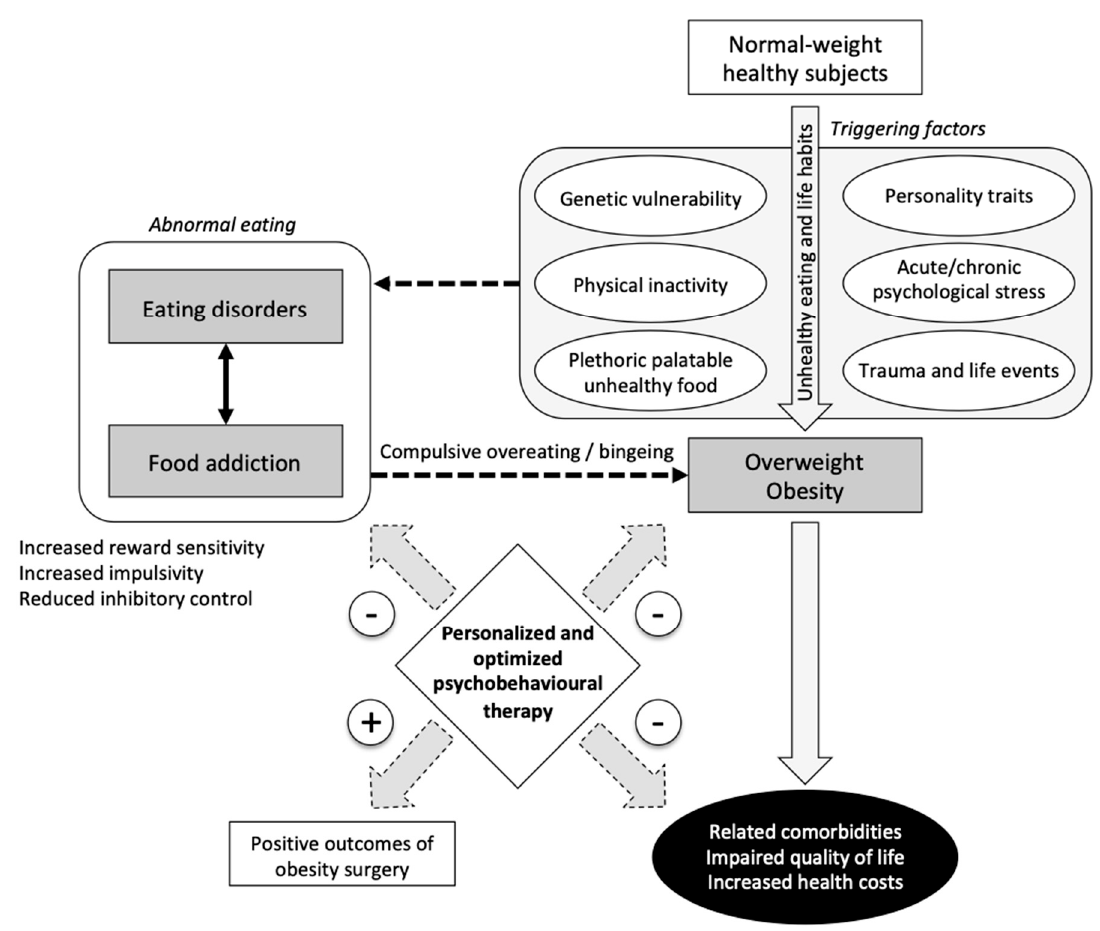
Figure 1. Food addiction as a causative or contributive factor for overweight and obesity. A personalized and optimized psychobehavioral therapy in patients with food addiction may help in preventing overweight and obesity, reducing their related comorbidities and related costs, and improving outcomes of obesity surgery. Dotted lines indicate connections for which published data are lacking or insufficient.